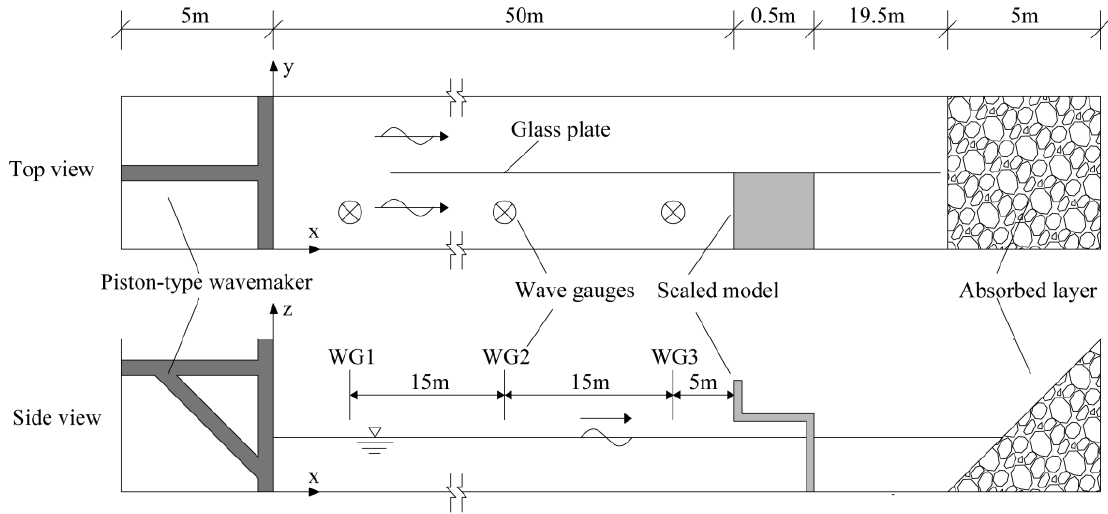
Figure 1. Experimental setup in the wave flume.